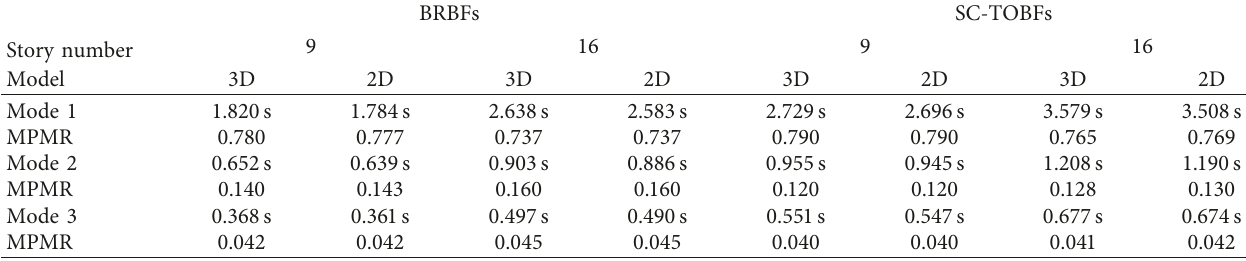
Table 2: Comparison of modal analysis.